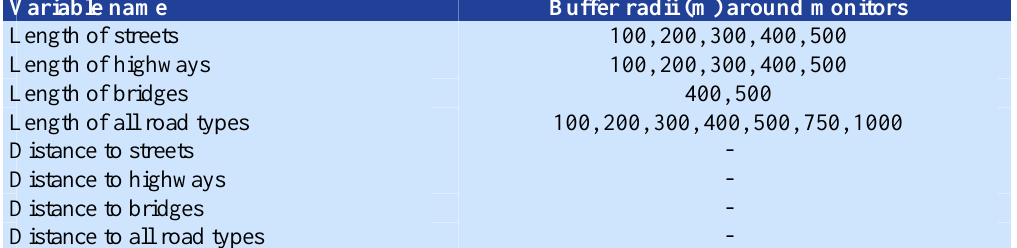
Table 1. Summary of the traffic measures variables